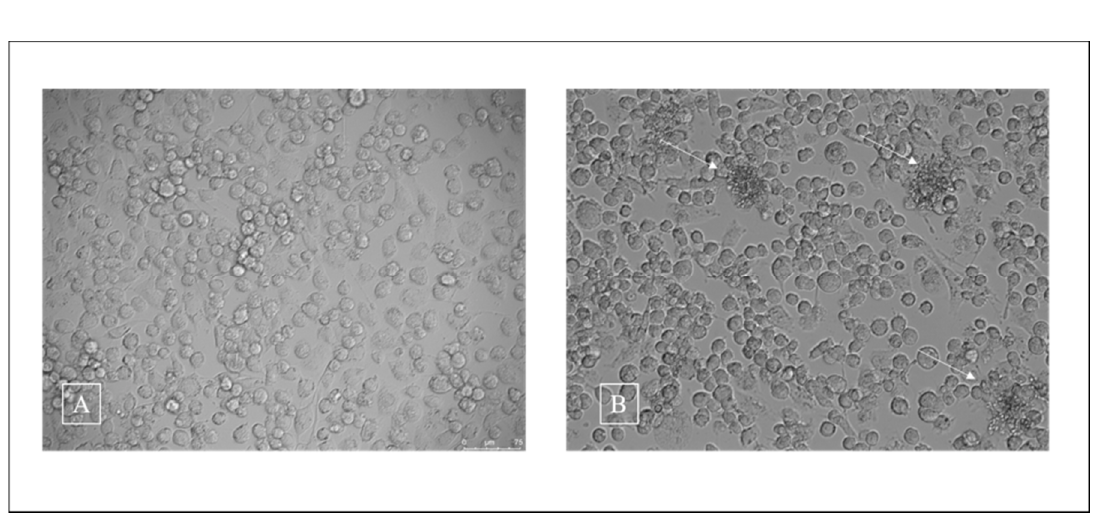
Figure 3. Co-culture of inactivated Trichophyton rubrum microconidia with THP-1 cells for 24 h. ( A ): THP-1 cell line (magnification 400×). ( B ): Co-culture. The arrows indicate fungal elements in contact with macrophages (magnification 400×).